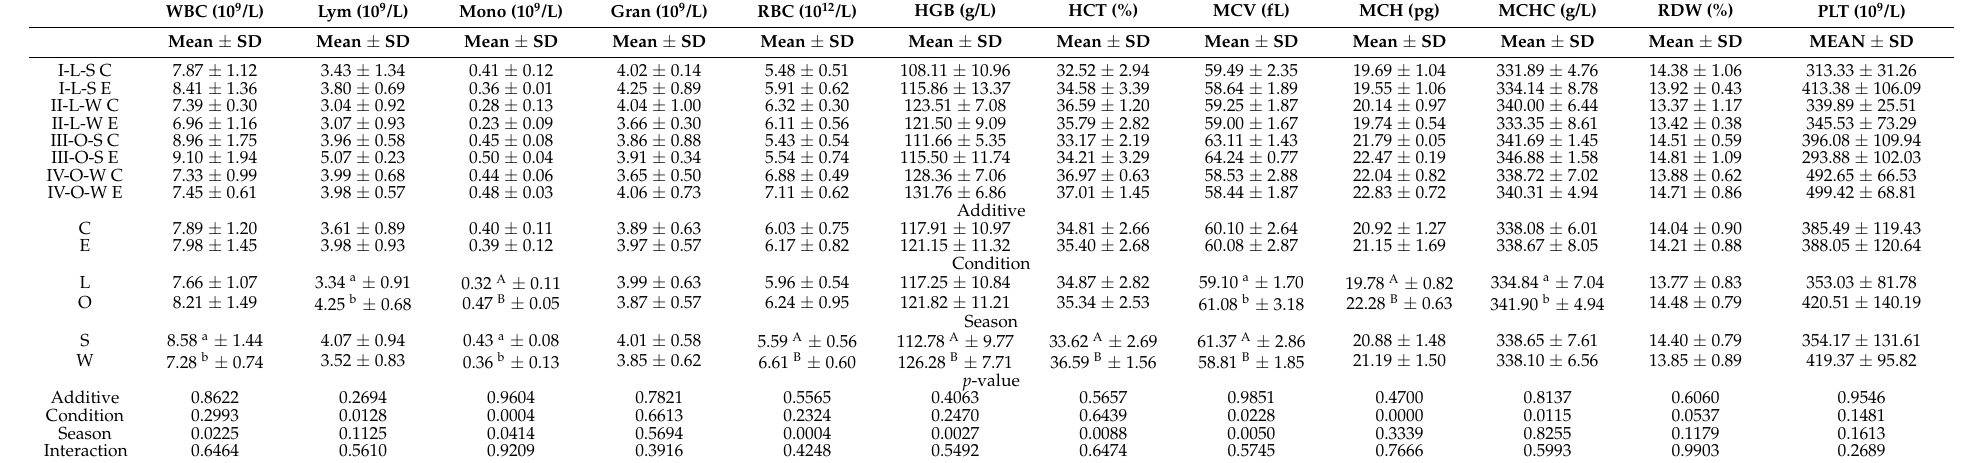
Table 4. Blood count results of white termond